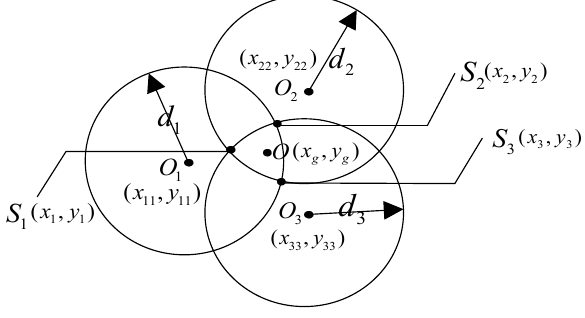
Figure 2. Schematic diagram of triangular centroid positioning.